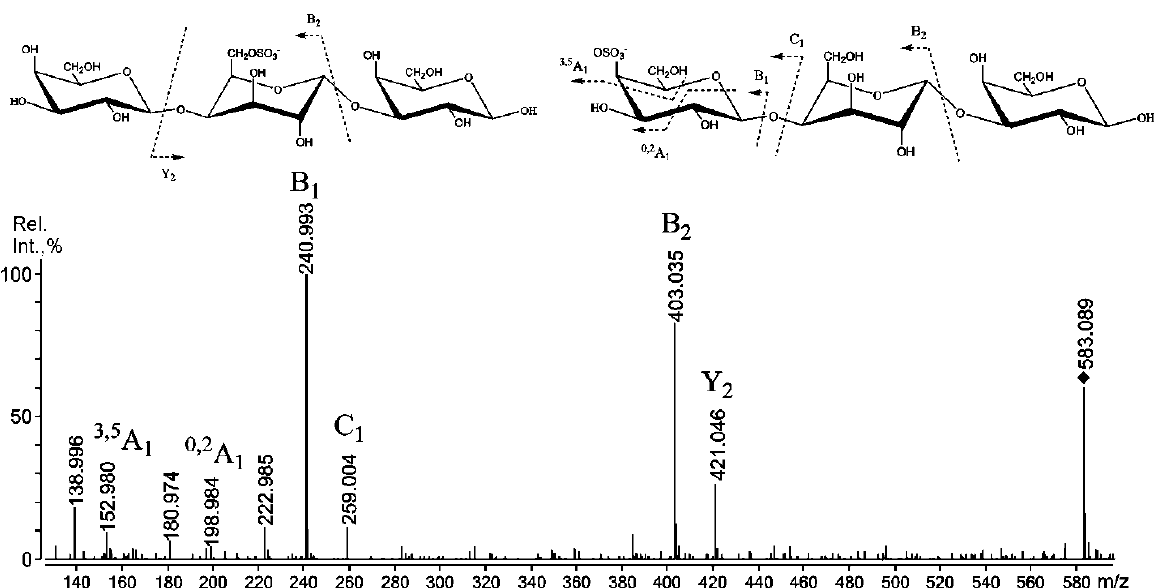
Figure 3. Negative-ion tandem ESIMS of ion at m/z 583.089, obtained through mild acid hydrolysis from RF-CRG.